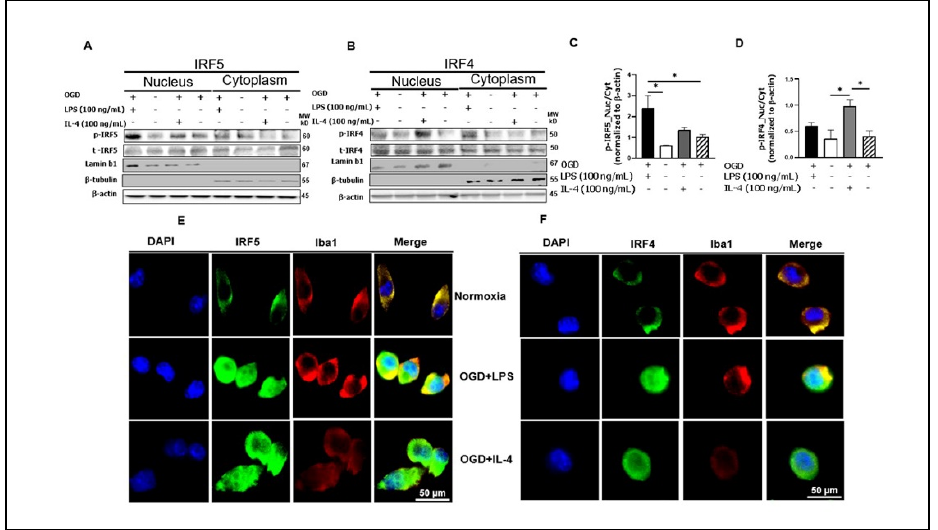
Figure 3. Microglial IRF5 and IRF4 translocate from the cytoplasm to the nucleus. ( A, B ) Cell homogenates were fractionated to nuclear and cytoplasmic portions and Western blot performed in each fraction for p-IRF5/4 and t-IRF5/4. The OD of each band was normalized to β-actin first, and then the quantitative ratio of nuclear/cytoplasmic p-IRF5 ( C ) and nuclear/cytoplasmic p-IRF4 ( D ) were presented. Immunocytochemistry for IRF5 ( E ) and IRF4 ( F ) in microglia showing cytosolic and nuclear expression. Western blot data were from 3 independent experiments. * p < 0.05; One-way ANOVA. Lamin b1 and β-tubulin are for the purity validation of nuclear and cytoplasmic fraction respectively. p , phosphorylated; t , total.